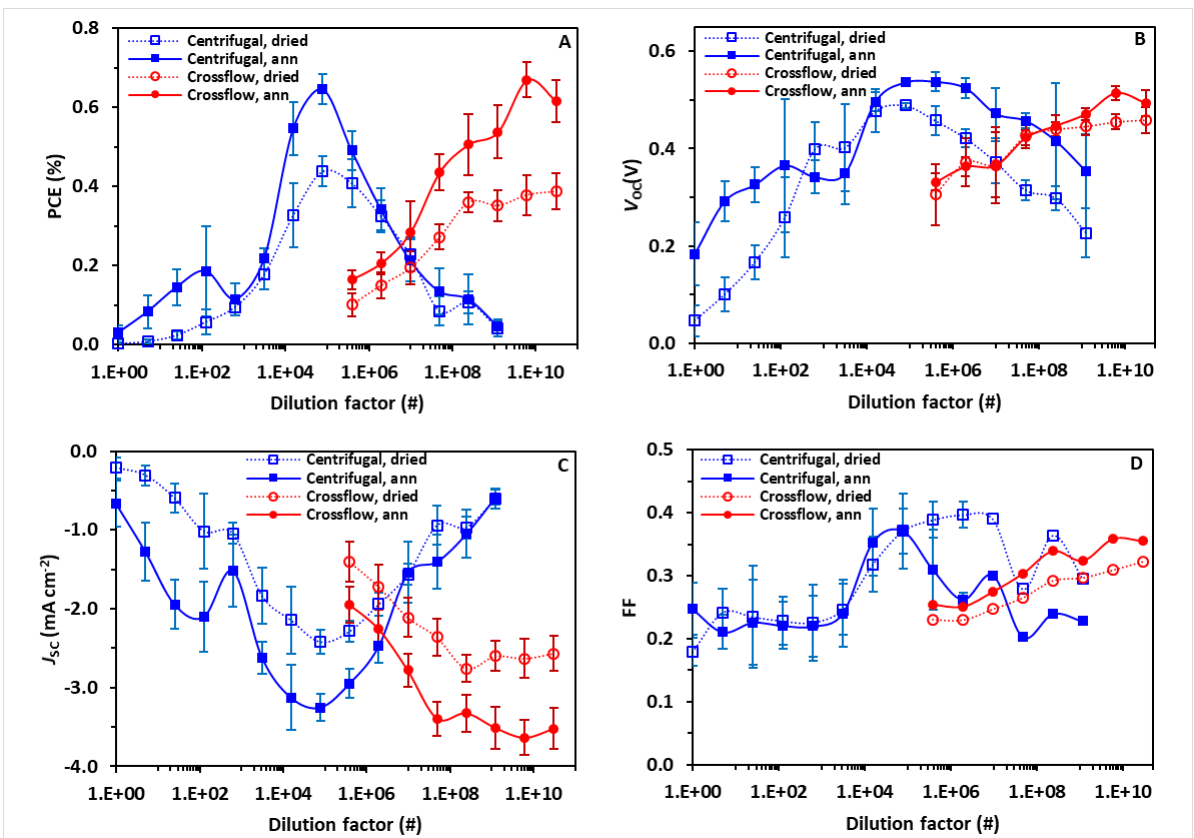
Figure 5: The performance parameters (PCE, V oc , J sc and FF) of P3HT:ICxA NP OPV devices for crossflow and centrifugal ultrafiltration methods plotted as red and blue lines, respectively. Solid line refers to annealed devices (140 °C, 4 min), and dotted line refers to dried (110 °C, 10 min) devices. The error bars represent the standard deviation of an average of 12 devices per sample.